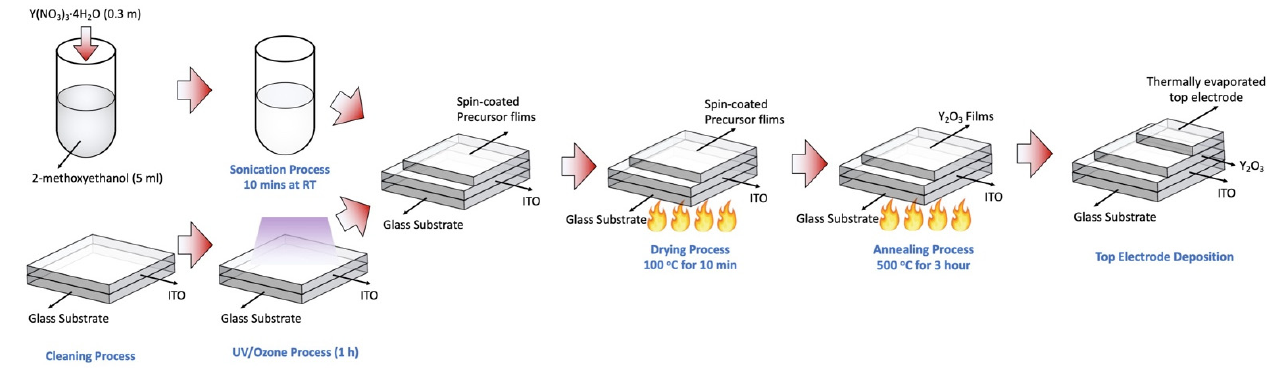
Figure 1. Fabrication process of sol-gel processed Y 2 O 3 RRAM devices.